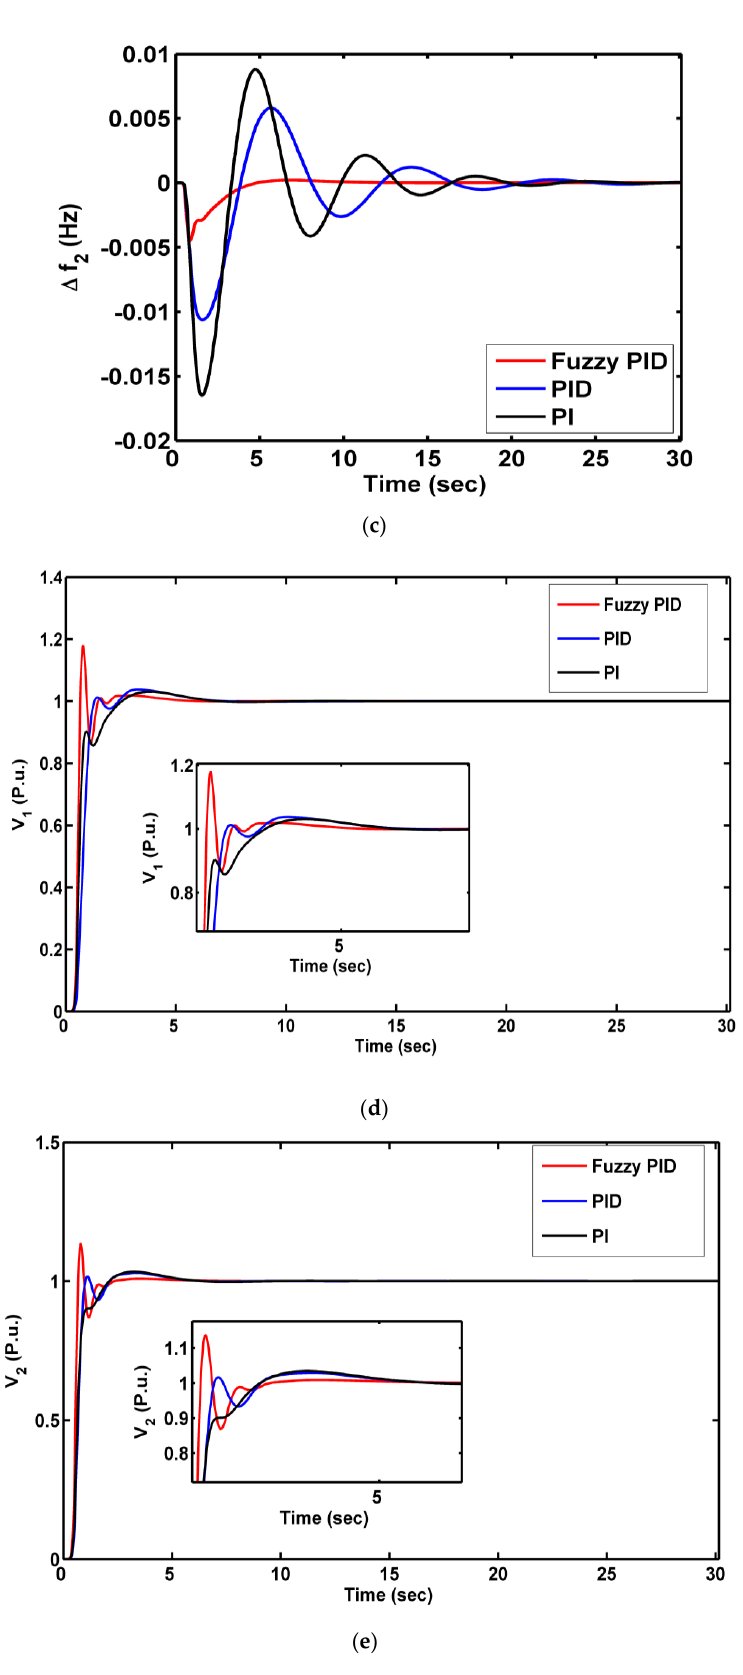
Figure 8. Responses for case-1: ( a ). ∆ f 1 , ( b ). ∆ Ptie 12 , ( c ). ∆ f 2 , ( d ). V 1 and ( e ). V 2.